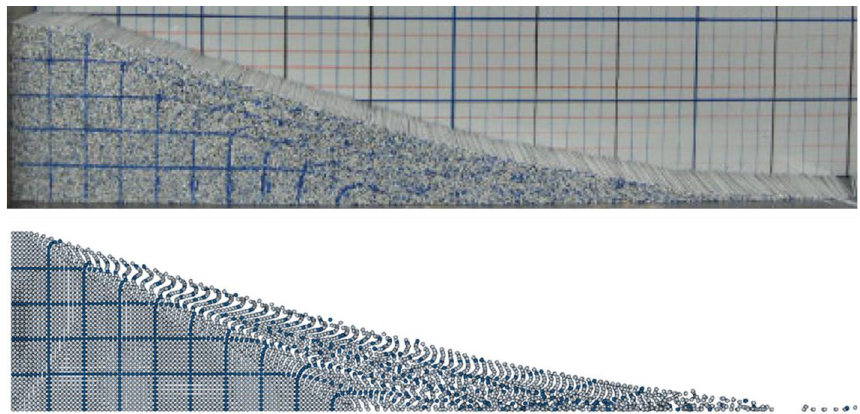
Fig. 13 Final configuration: (upper) experiment [87] and (lower) coupled L–SL RKPM simulation